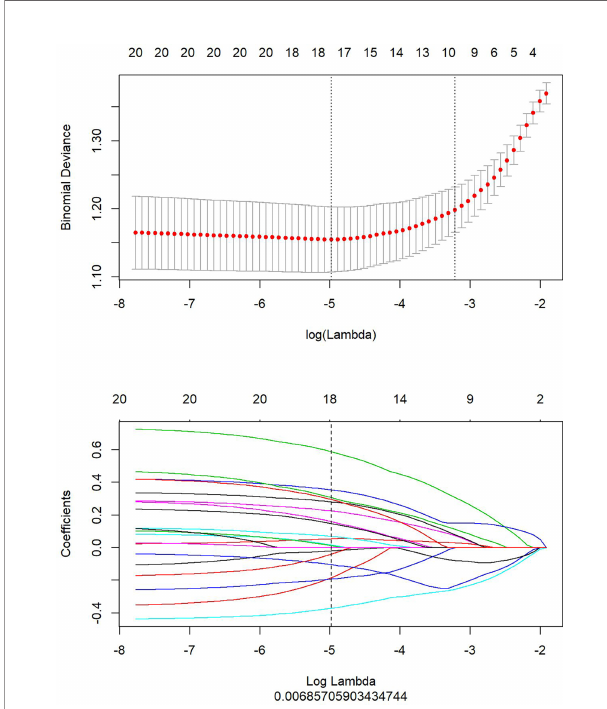
( Figure 6 ), for which the AUC of the training set was 0.79 (95%